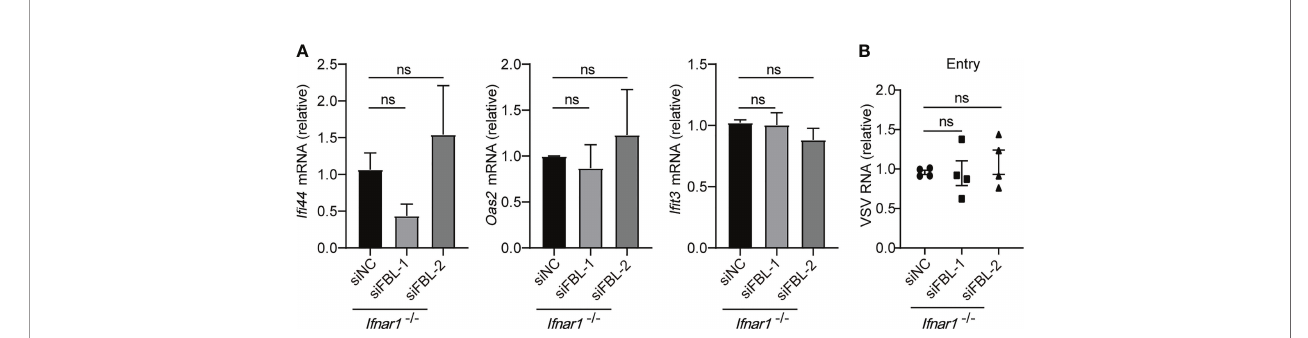
FIGURE 5 | Knockdown of FBL reduces viral entry by increasing ISGs expression through IFN-I signaling. (A) qRT-PCR analysis of I fi 44 , Oas2 , I fi t3 mRNA in Ifnar1 -/- mouse peritoneal macrophages transfected with the indicated siRNAs for 48 h (n=3); (B) VSV RNA levels in Ifnar1 -/- peritoneal macrophages transfected with the indicated siRNAs for 48 h and then infected with VSV for 30 min in 4°C. After removal of unbound virus, the temperature was increased to 37°C to allow internalization. Then quantify VSV RNA levels via qRT-PCR (n=4). Data are mean ± SEM of biologically independent samples. ns, not signi fi cant, two-tailed unpaired Student ’ s